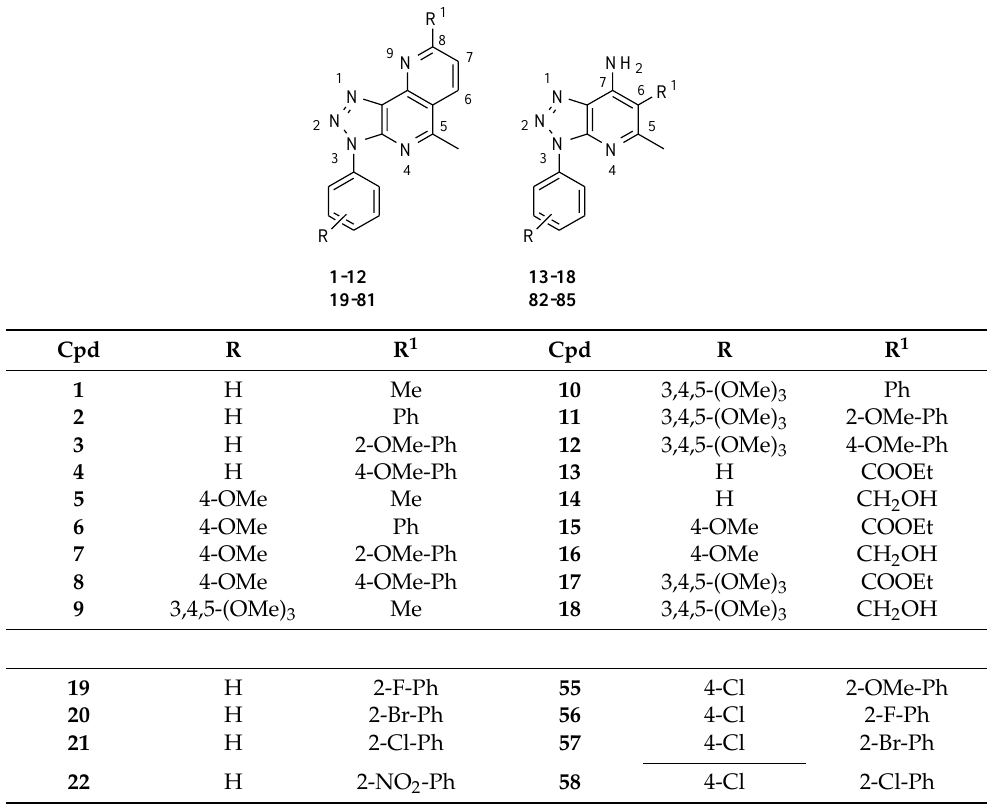
Figure 1. Graphical workflow of the applied in silico approaches on HSV-1 gD Pockets. Table 1. Synthetic ( 1 – 12 ) and designed ( 19 – 81 ) triazolo [4,5- h ][1,6]naphthyridines and synthetic ( 13 – 18 ) and designed ( 82 – 85 ) triazolo [4,5- b ] pyridines.